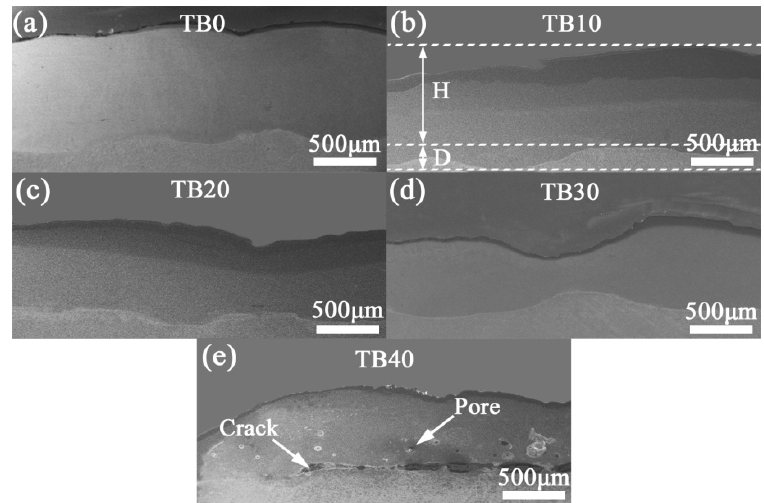
Figure 4. Cross-sectional morphologies of coatings with different TiB 2 particles content: ( a ) TB0, ( b ) TB10, ( c ) TB20, ( d ) TB30 and ( e ) TB40. Table 3. Height, depth and dilution rate of coatings with different TiB 2 particles content.